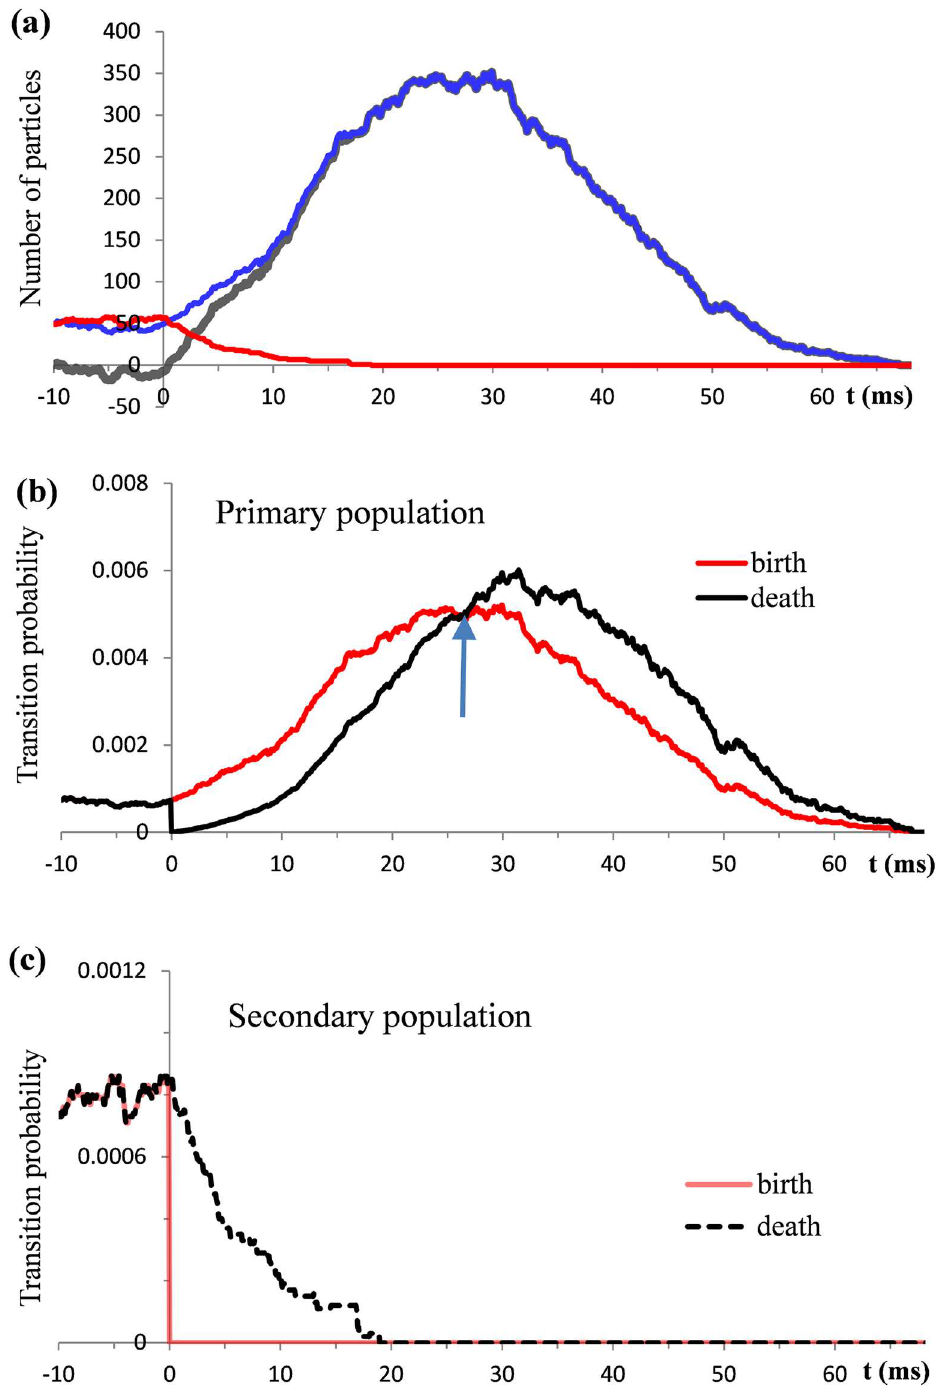
Fig 7. Numerical reconstructions of the temporal evolution of particle populations in a typical trial. Resting conditions computed from -10 ms are switched at t = 0 to the transient conditions. (a) Blue, red, and black lines show functions X P ( t ), X S ( t ) and X N ( t ), respectively. (b, c) Time courses of the underlying transition probabilities.